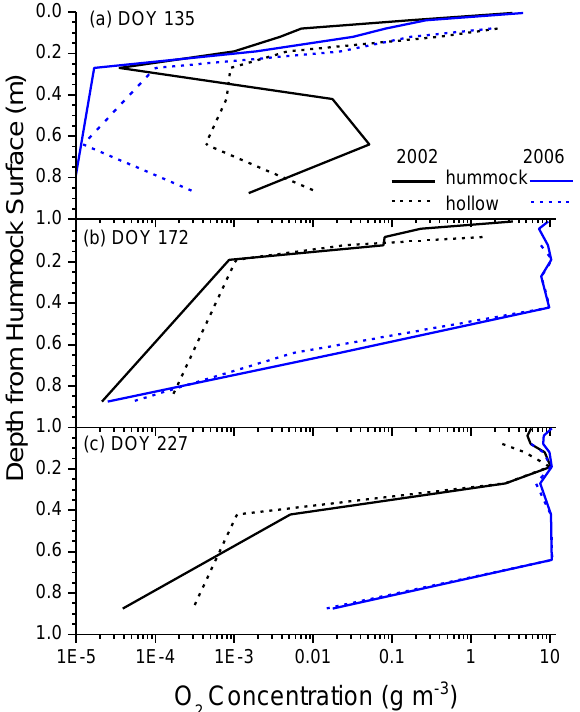
Fig. 8. Vertical profiles of aqueous O 2 concentration ([O 2s ]) mod- elled below hummocks and hollows on DOY 172 and 227 of 2002 and 2006.